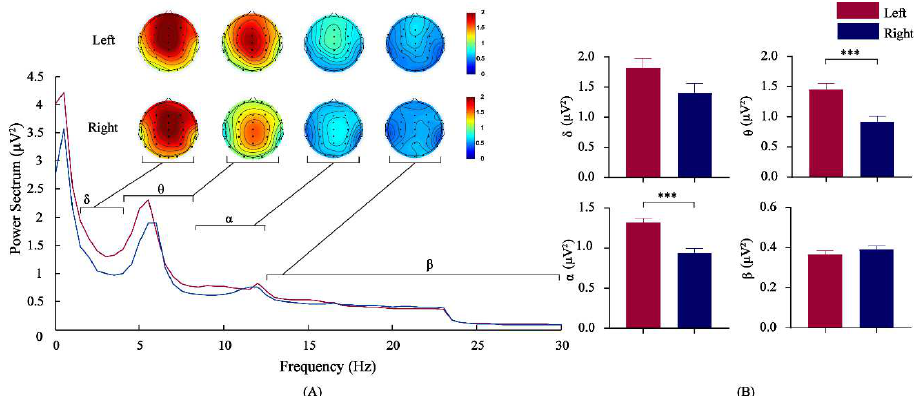
that in the right-paddlers group [ M = 0.939, 95%CL (0.825, 1.054)], p < 0.001. The results are shown in Figure 2.